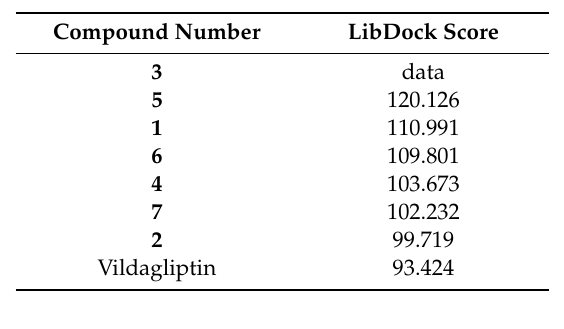
Table 2. LibDock scores for compounds 1 – 7 and vildagliptin.